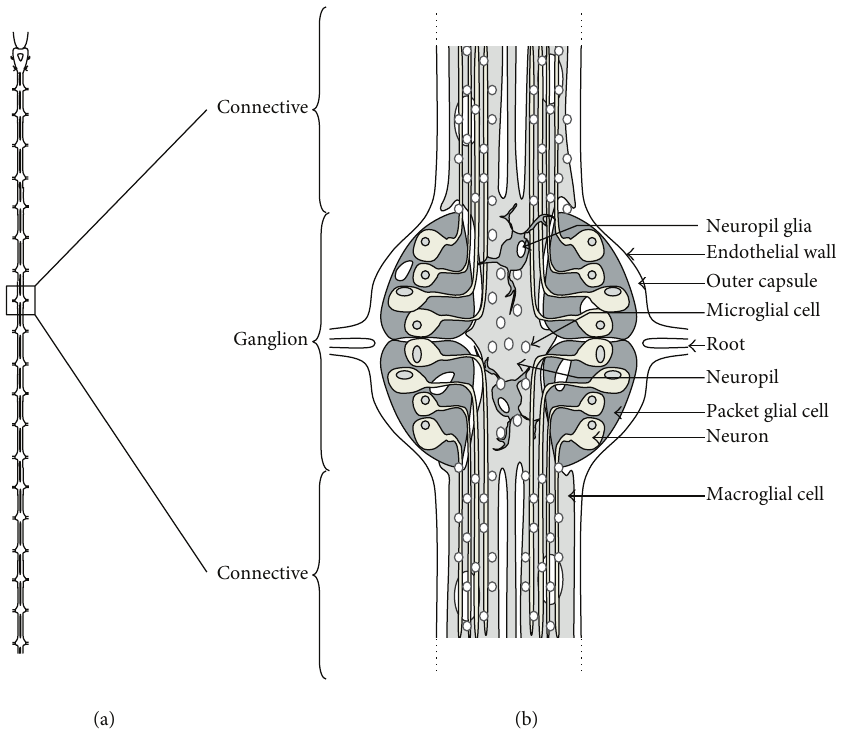
Figure 1: (a) Diagram of leech nervous system containing a head ganglion, 21 body ganglia, and 7 fused tail ganglia joined by connectives. (b) Thedorsalviewoftheganglionpresentspacketglialcellsenvelopingneuroncellbodies.Theaxonalprocessespassingthroughtheneuropilare prolonged into connectives. The neuropil lies dorsomedially and contains two macroglial cells. Thousands of microglial cells are distributed in ganglia and connectives. The nervous system is enclosed in the outer capsule which is covered on the outside by a visceral layer of the endothelium (lining the ventral blood sinus). (Reprinted, with permission, from